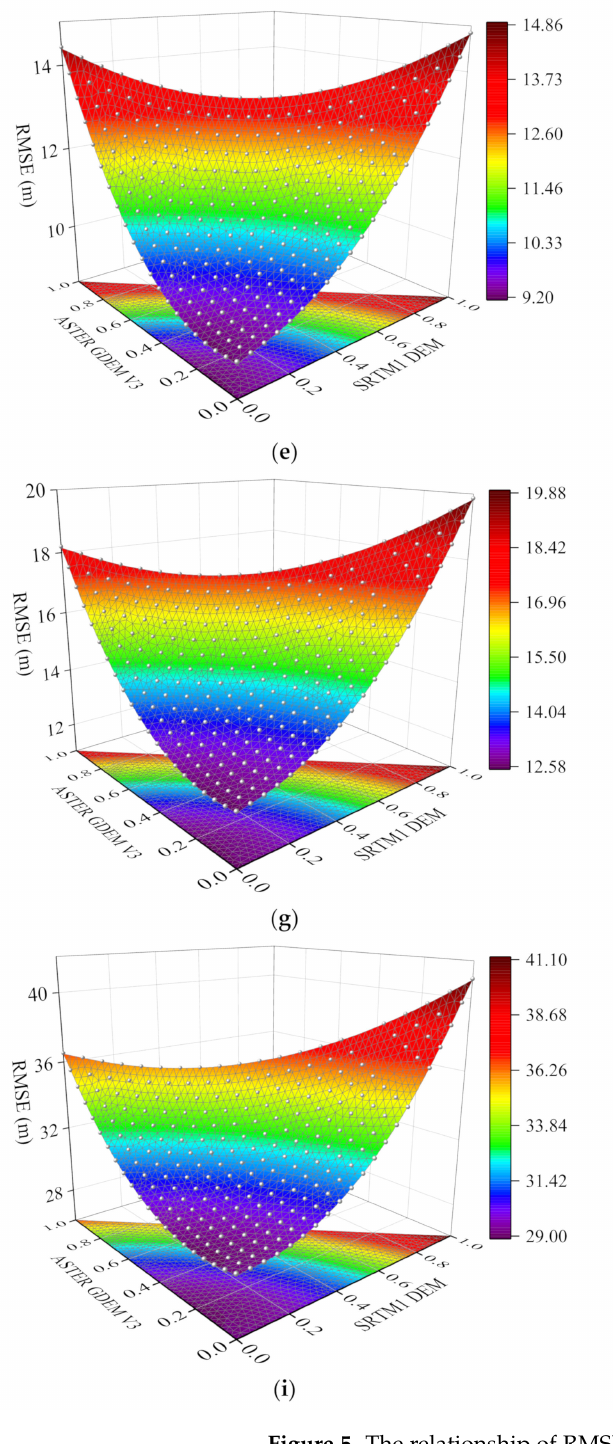
Figure 5. The relationship of RMSE with weight coefficient for each slope grading area. ( a ) 0 ◦ –5 ◦ ; ( b ) 5 ◦ –10 ◦ ; ( c ) 10 ◦ –15 ◦ ; ( d ) 15 ◦ –20 ◦ ; ( e ) 20 ◦ –25 ◦ ; ( f ) 25 ◦ –30 ◦ ; ( g ) 30 ◦ –35 ◦ ; ( h ) 35 ◦ –45 ◦ ; ( i ) 45 ◦ –90 ◦